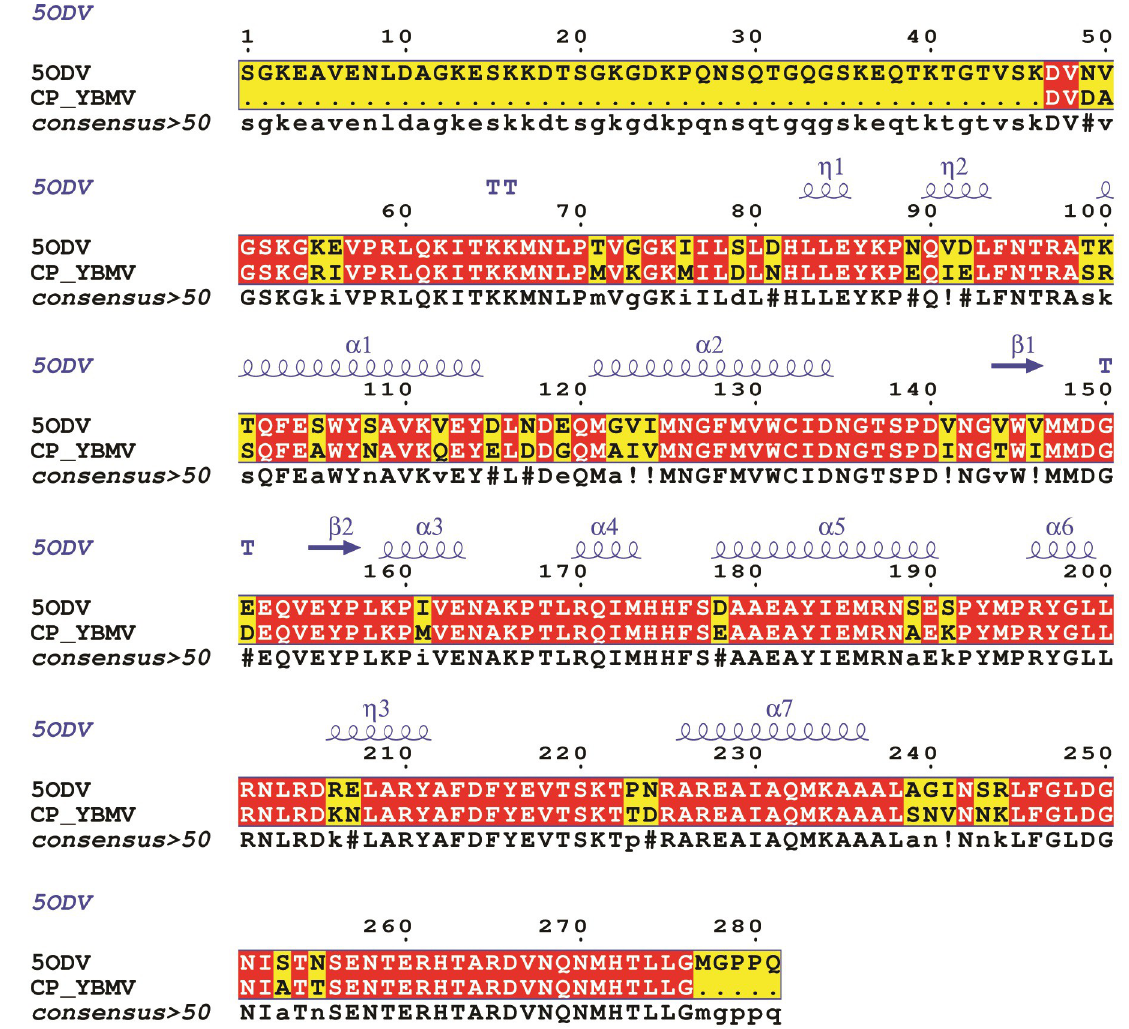
Fig 2. Target-template alignment of YMBV CP (coat protein) sequence with 5ODV using ESPript 3.0 software.